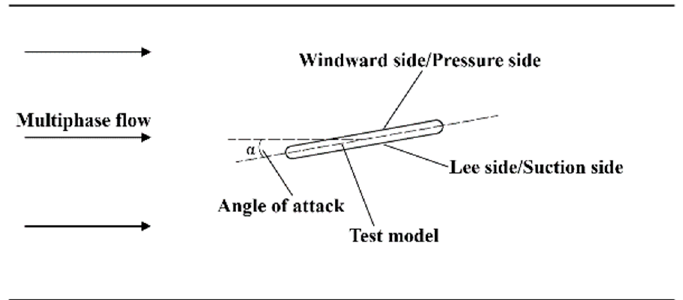
Figure 6. Schematic of multiphase flow and angle of attack.